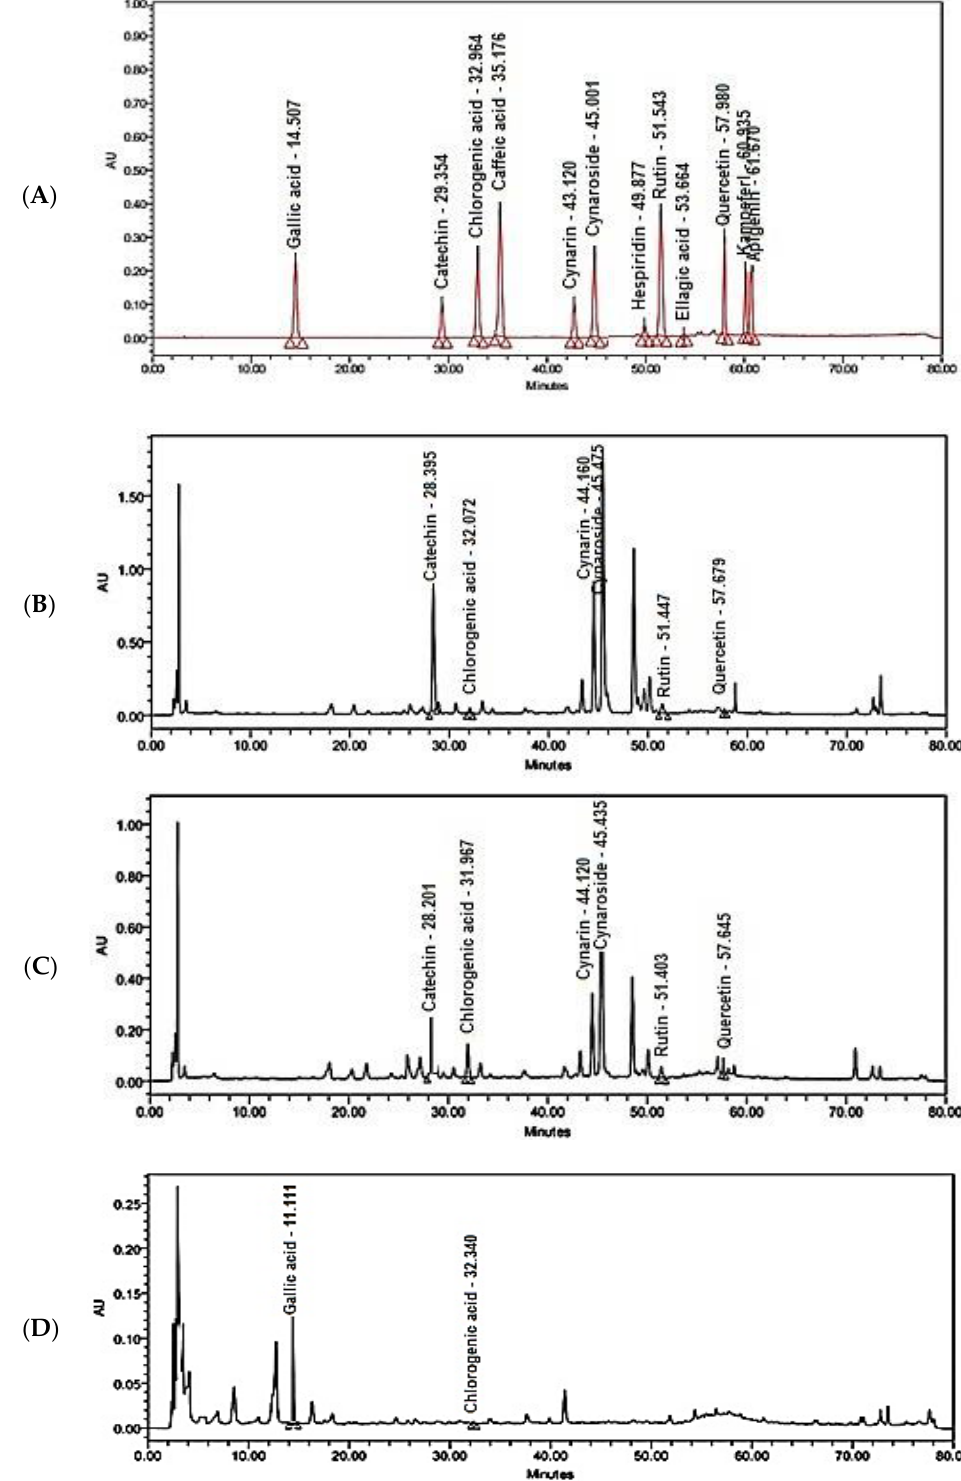
Figure 1. HPLC-DAD chromatograms: ( A ) Chromatogram of ten reference standards of polyphenols; ( B ) Chromatogram of polyphenols in flower crude extract; ( C ) Chromatogram of polyphenols in bract crude extract; ( D ) Chromatogram of polyphenols in stem crude extract.